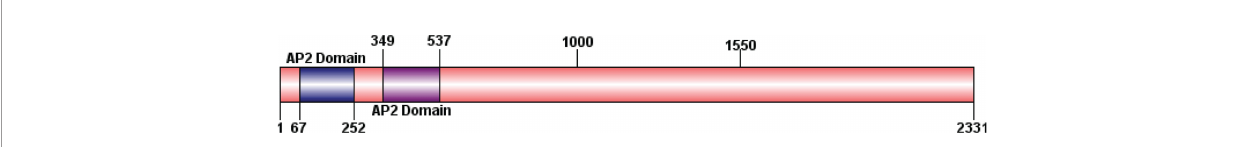
FIGURE 10 | Prediction of conserved domains in DpAP2. The diagram was constructed based on a complete protein sequence of DpAP2 using the DOG 2.0 program. The conserved domain was analyzed by the NCBI CD-Search tool.